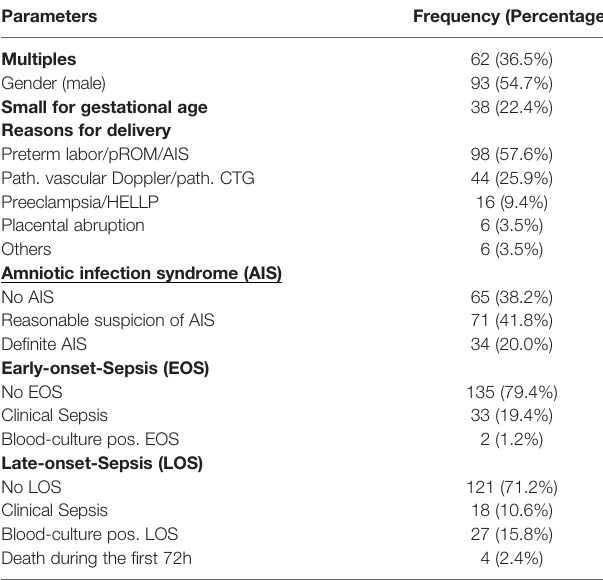
TABLE 1 | Clinical characteristics of the included preterm